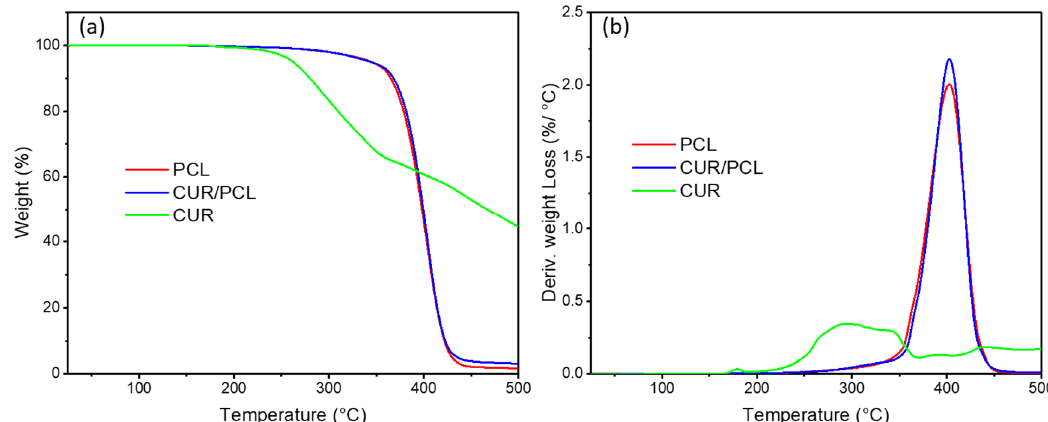
Figure 8. ( a ) Thermogravimetric analysis (TGA) thermograms and ( b ) derivative thermogravimetric graphs of curcumin (CUR), blank, and curcumin-loaded PCL scaffold (7%, w / w ).